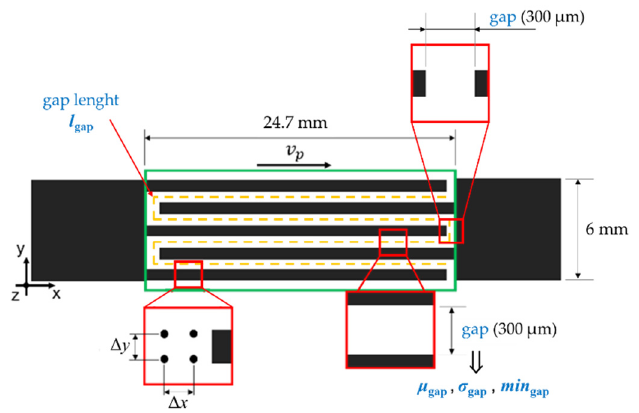
Figure 1. Interdigital